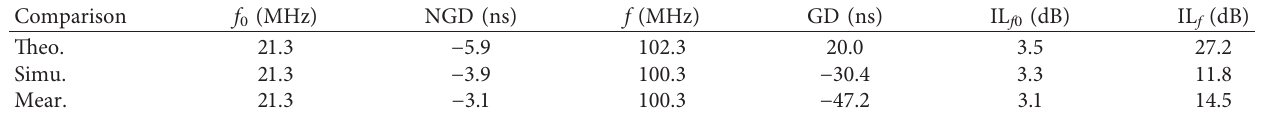
Figure 17: S parameters of the band-stop filter with negative high-pass delay at different C Table 9: Comparison results of theory, simulation, and measurement.